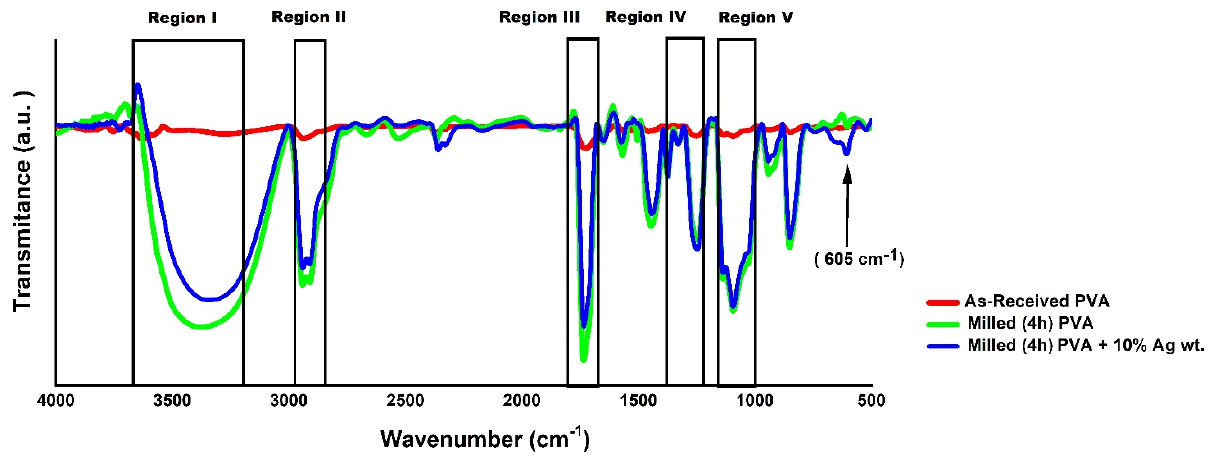
Figure 7. FTIR spectra of as–received PVA powder samples, PVA mechanical alloyed for 4 h, with 10% wt. Ag and without Ag.